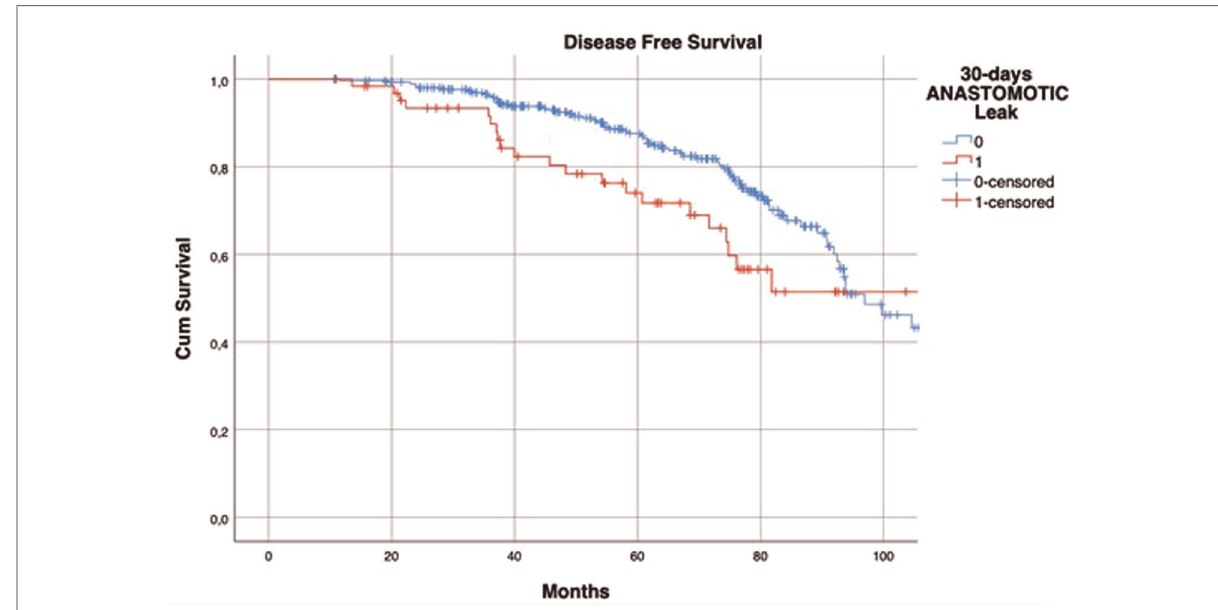
FIGURE 1 Kaplan – Meier curves of local recurrence-free survival, according to the occurrence of postoperative anastomotic leakage. p <0.001 (log rank